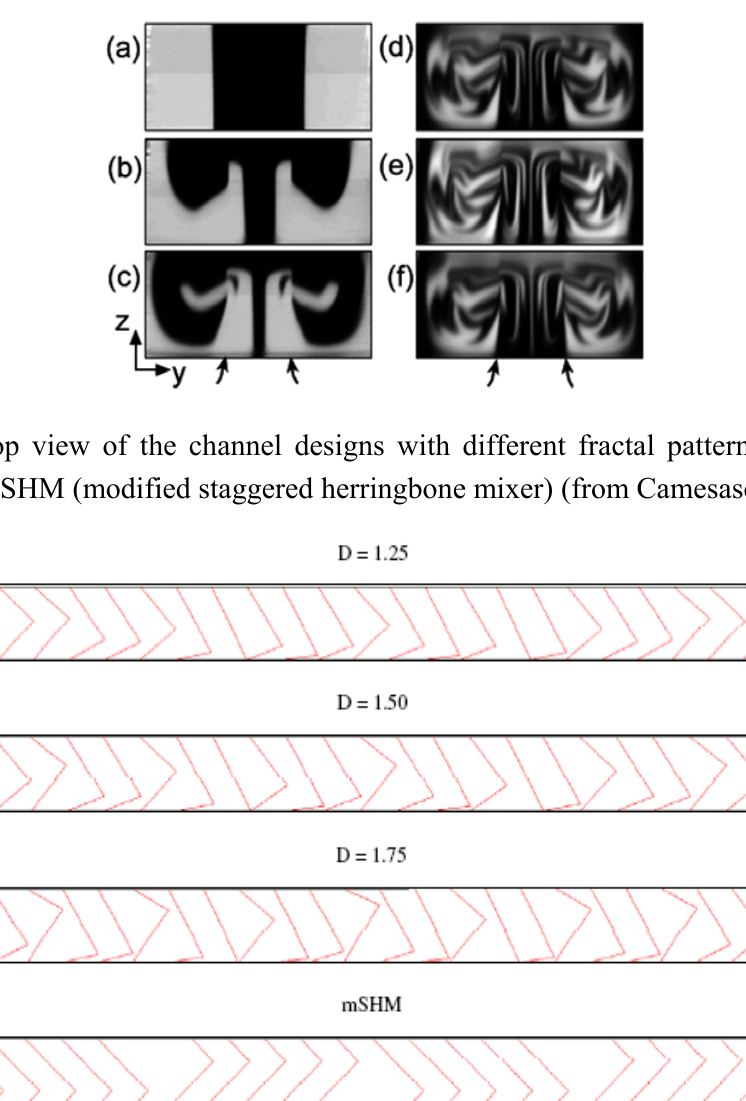
Figure 15. Development of the striation pattern inside the channel (from a to f) showing chaotic advection (from Simonnet and Groisman [32]).